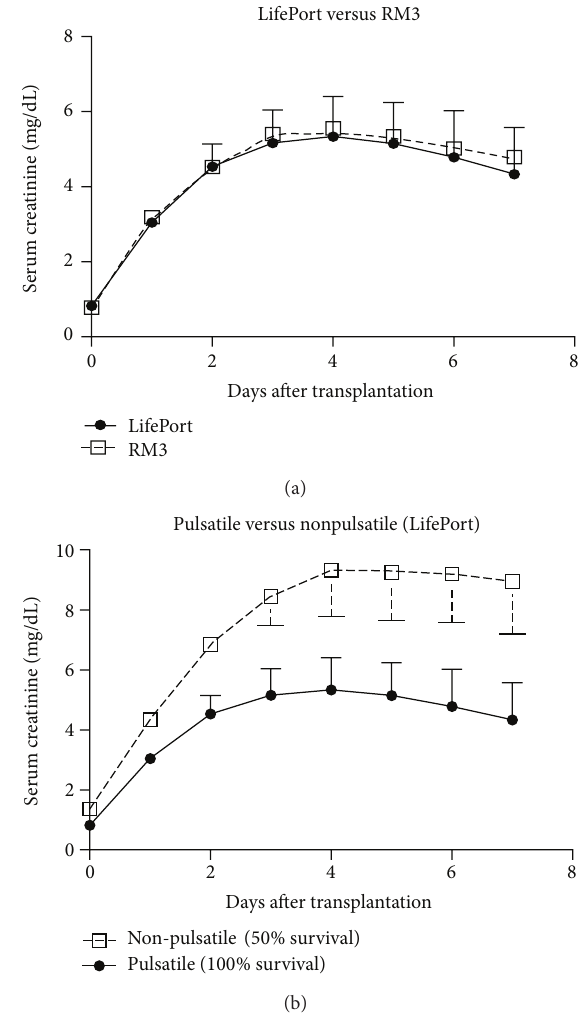
Figure 3: Daily serum creatinine values after kidney autotransplan- tation after DCD donation. Kidneys were perfused for 24 hours usingtheLifePort(OpenSquares)ortheRM3(SolidCircles).Values aremean ± S.D.andrepresent8dogspergroup(Figure 3(a)).Similar data (Figure 3(b)) are shown for a LifePort operated under either constant pressure (nonpulsatile flow) or pulsatile flow conditions (both at 30mmHg). The values are statistically different between the first 3 corresponding post-operative days. The survival in the pulsatile and nonpulsatile groups were 100% (8/8) and 50% (2/4), respectively ( 𝑃 = 0.09